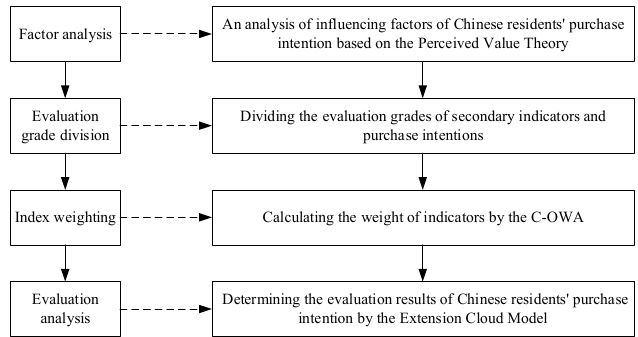
Figure 2. Research framework.